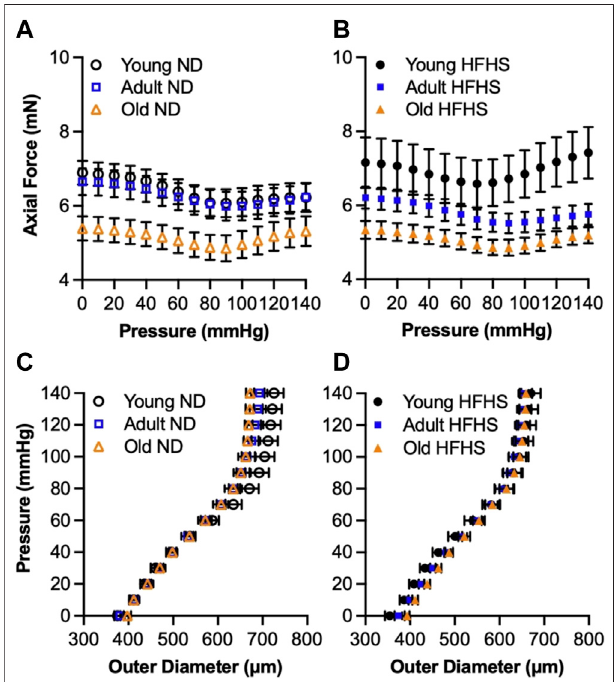
FIGURE 2 | Average (mean ± SEM) axial force-pressure (A,B) and pressure-outer diameter (C,D) responses at in vivo axial stretch ratio for the age (young, adult and old) and diet (ND and HFHS)